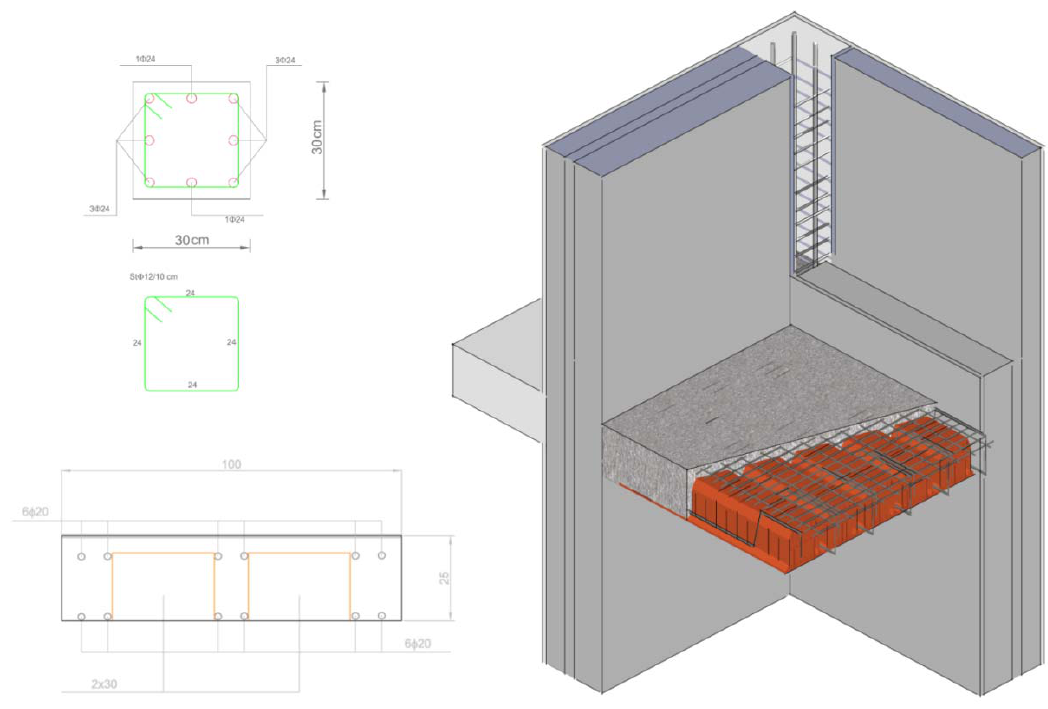
Figure 3. Geometry considered in the simulations, with column and slab